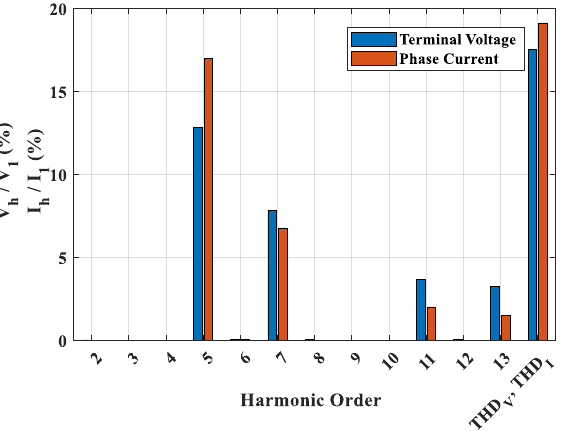
Figure 3. Terminal voltage harmonic spectrum of the SG under the no-loading condition.